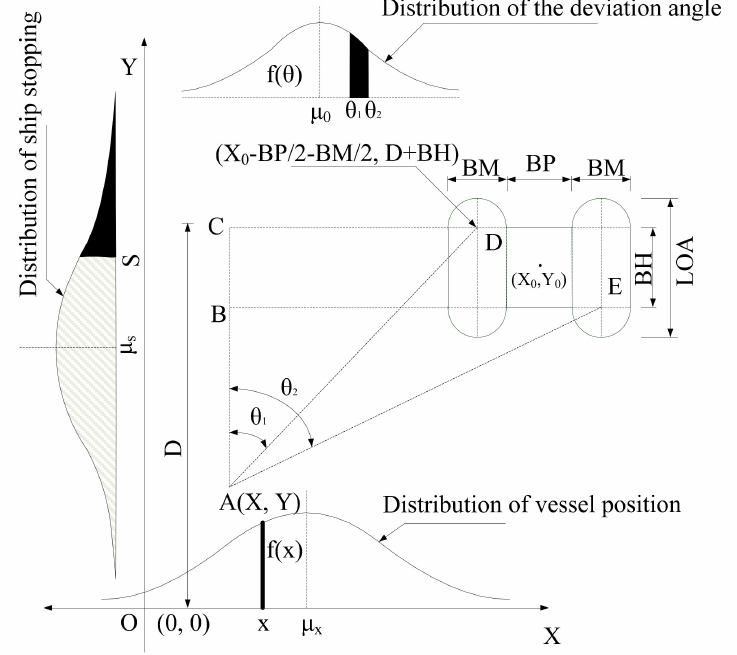
Figure 6. Three random variables collision model